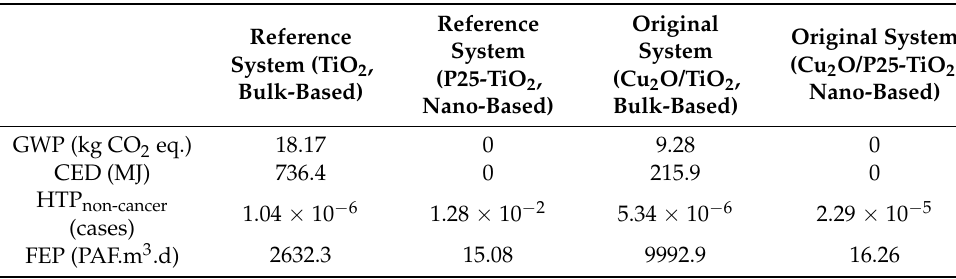
Table 5. LCA results per functional